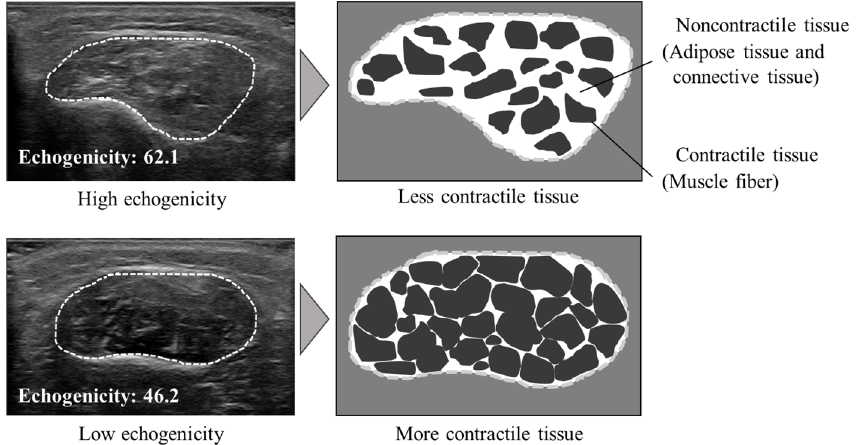
Figure 4. Muscle echogenicity in the ultrasound image. As shown in the upper illustration, the higher the value of muscle echogenicity, the brighter the image appears, indicating more noncontractile tissue in the muscle. As shown in the lower illustration, the lower the value of the muscle echogenicity, the darker it appears in the image, indicating less noncontractile tissue in the muscle. Surface electromyography was performed using BIMUTAS-Video (Kissei Comtec Co., Ltd., Nagano Japan), and the recorded waveforms were processed for noise using a 10–500 Hz bandpass filter. Isometric ankle eversion under maximal effort was performed during the stable 1 s isometric maximal contraction of the obtained waveform was set at 100%. Next, the results of the muscle activity obtained by ankle eversion in the lateral position were normalized as the percentage of maximum voluntary contraction. The average of three measurements was used as the representative value. The ankle evertor strength was defined as the average of three values obtained from the handheld dynamometer divided by the body weight (N/kg) for standardization to reduce individual